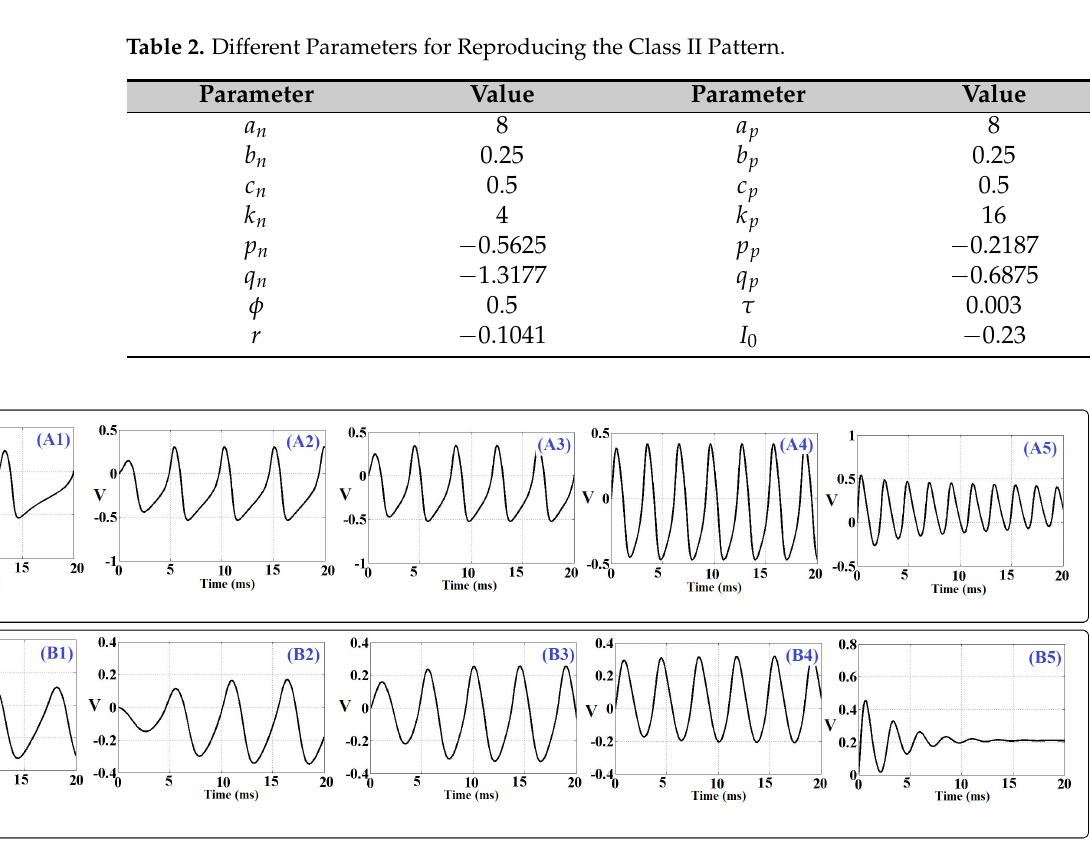
Figure 1. Spike-based signals of the DSSN model. ( A1 – A5 ): Spiking patterns of Class I mode for different stimulation current as: I Stimulus = 0.1, I Stimulus = 0.2, I Stimulus = 0.5, I Stimulus = 1, and I Stimulus = 2, respectively. ( B1 – B5 ): Spiking patterns of Class II mode for different stimulation current as: I Stimulus = 0.1, I Stimulus = 0.2, I Stimulus = 0.5, I Stimulus = 1, and I Stimulus = 2,